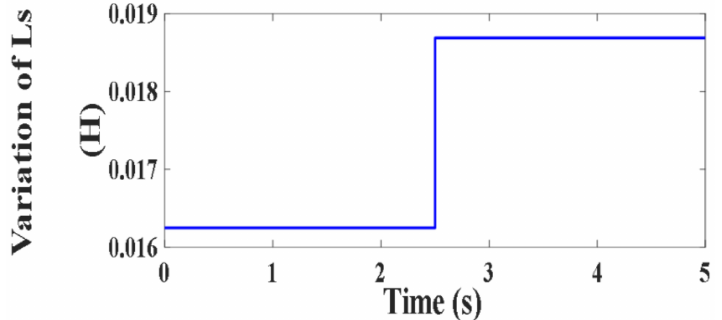
Figure 156. Variation of L s (H).